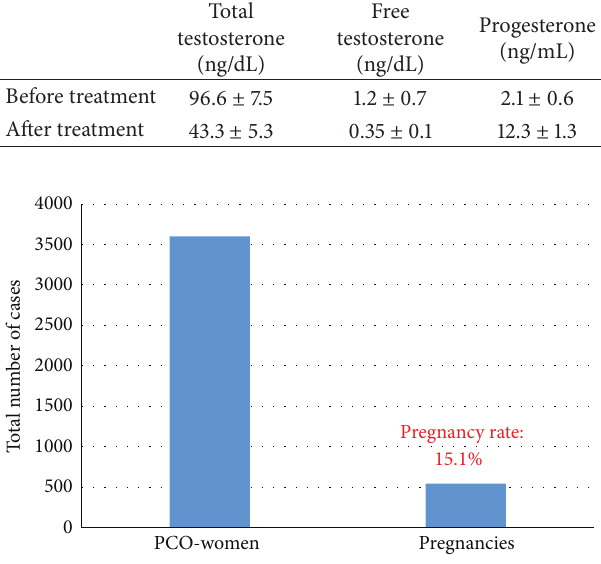
Figure 2: Number of patients and pregnancy